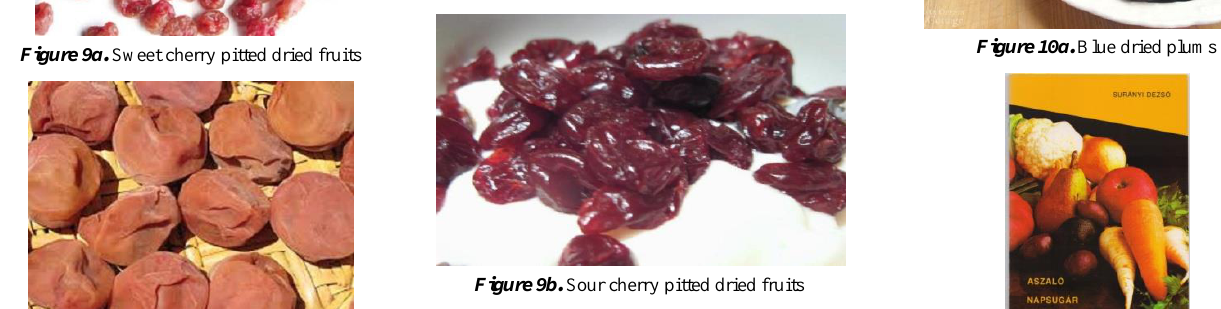
Figure 10a. Blue dried plums